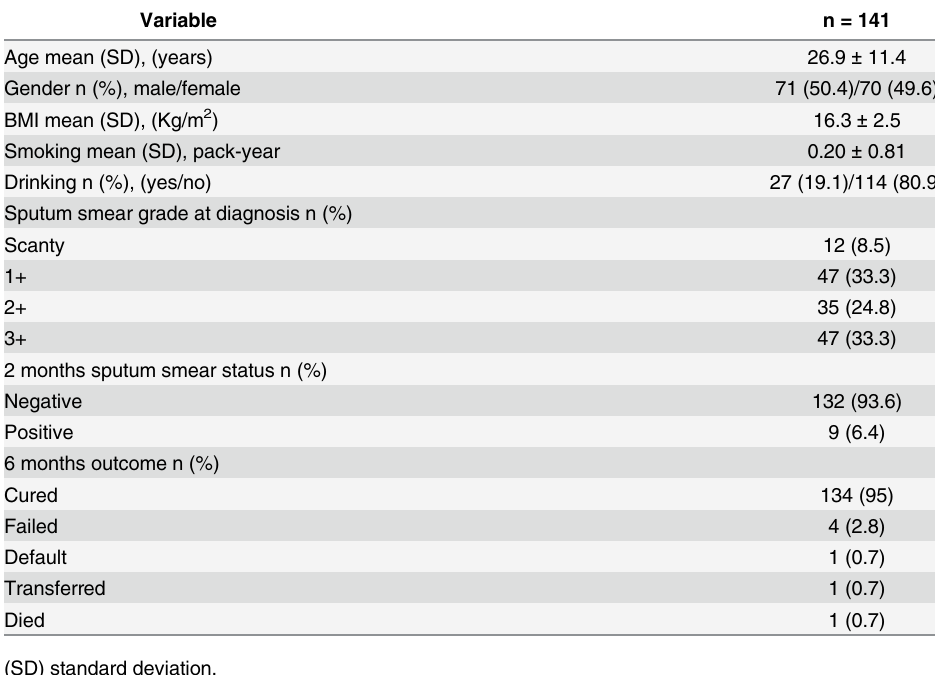
Table 1. Characteristics of study